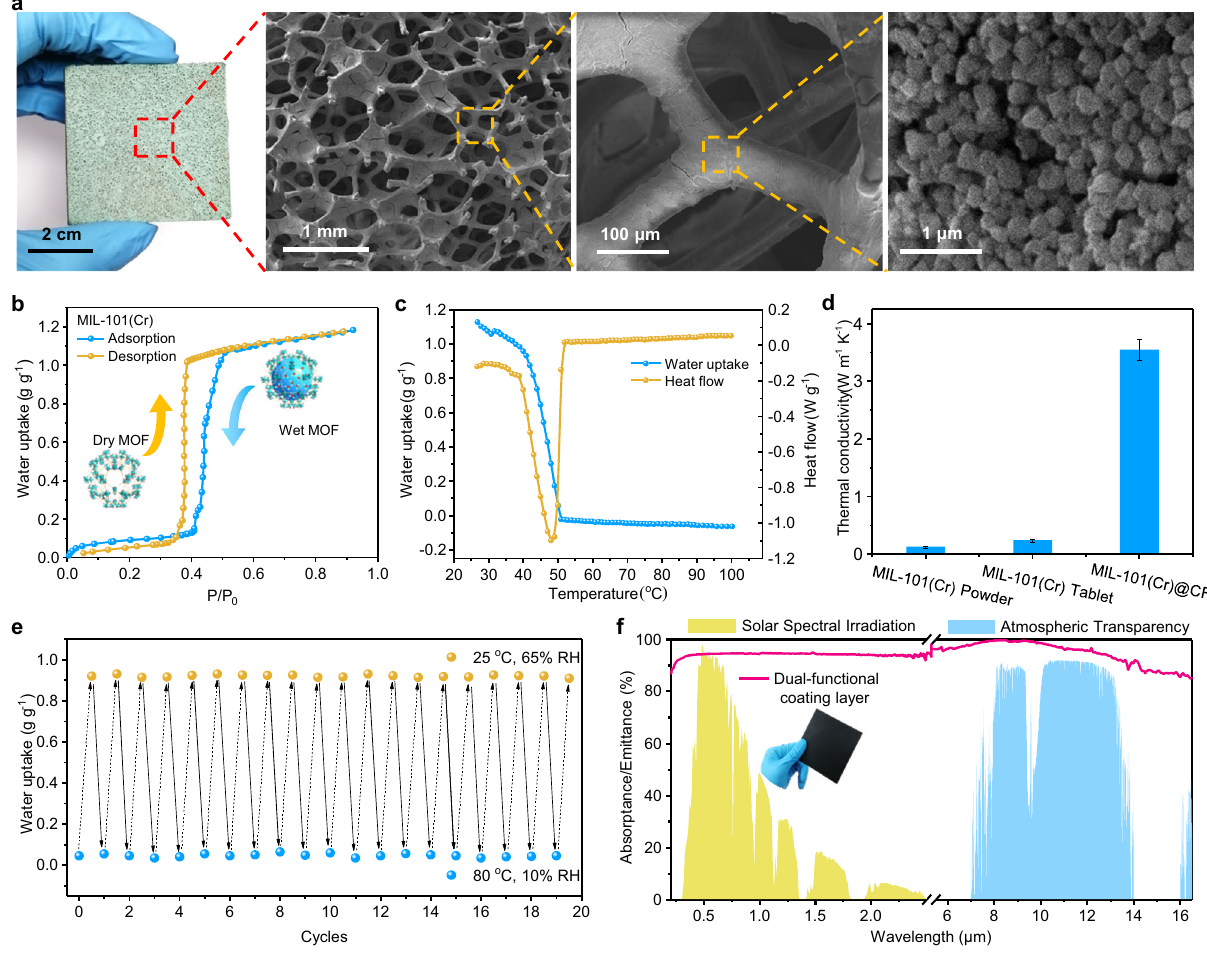
Fig. 2 | Synthesis and characterizationofMIL-101(Cr)@CF composite for water sorption. a Digital photograph and SEM images of MIL-101(Cr)@CF composite (size: 50×50×5mm). b Moisture sorption-desorption isotherms of MIL- 101(Cr) with typical S-shaped characteristics and high water uptake at 25 °C. c Thermogravimetricanalysiscoupledwithdifferentialscanningcalorimetry(TGA- DSC) of MIL-101(Cr) during the moisture desorption process. d Thermal